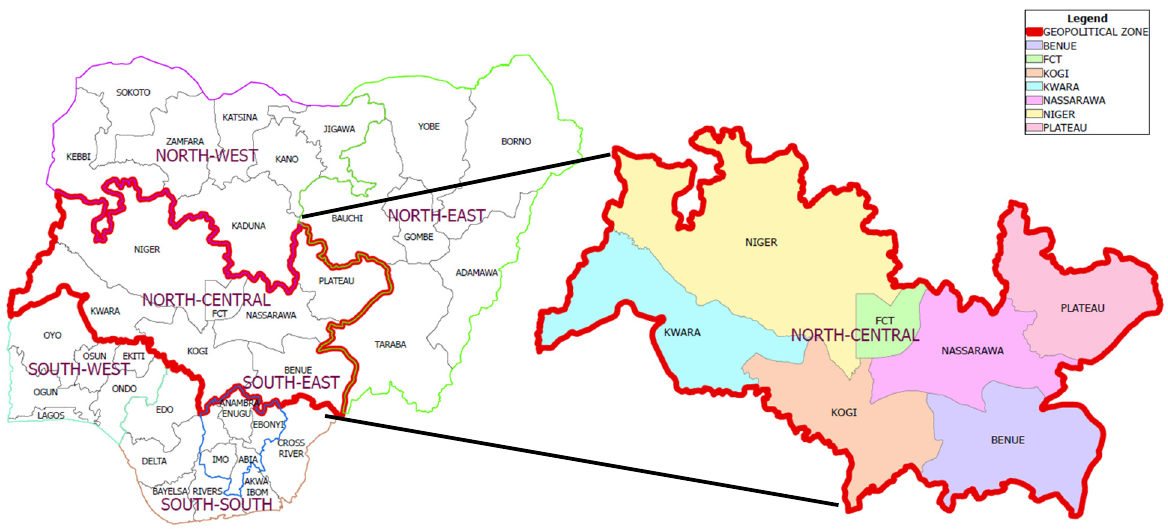
Figure 1. Map of Nigeria with a call-out map of the North Central zone. Table 1. Descriptive statistics of cultured bacteria found in faecal samples collected from smallholder